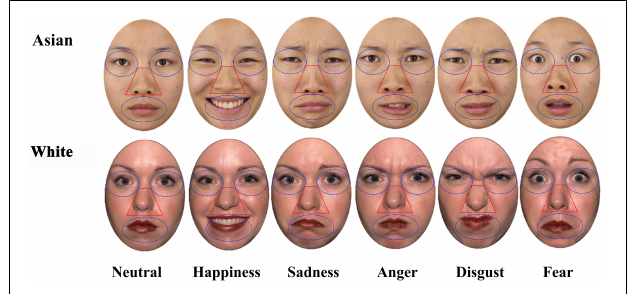
FIGURE 1 | Areas of interest (AOIs, i.e., eyes, nose, and mouth) for the different face expressions (Neutral, Happiness, Sadness, Anger, Disgust, and Fear) for Asian and White example images.